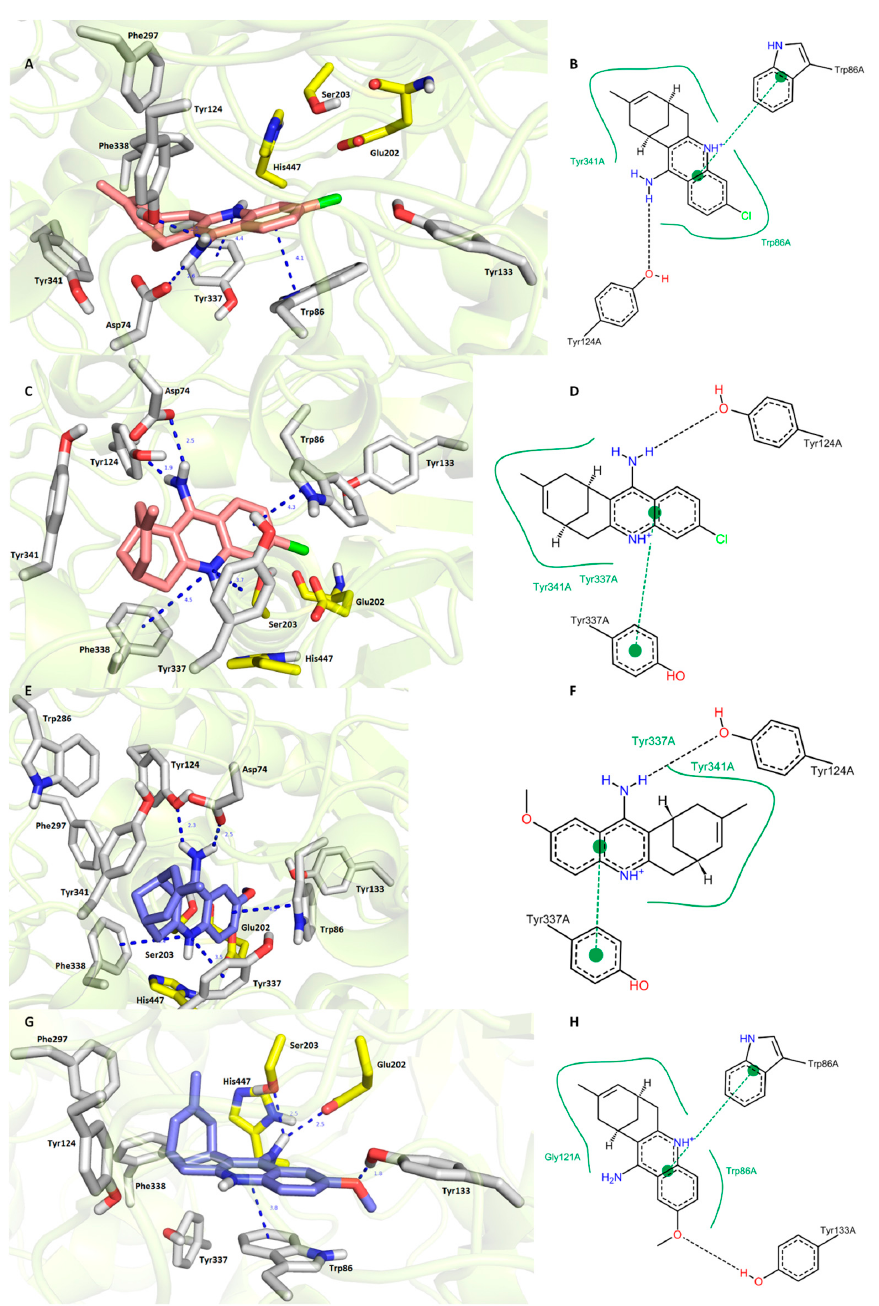
Figure 4. Docking results for HupY (( A , B )—7 R ,11 R -HupY; ( C , D )—7 S ,11 S -HupY) and 1 (( E , F )—7 S ,11 S - 1 ; ( G , H )—7 R ,11 R - 1 ) within h AChE active site (PDB ID: 4EY7). Generally to ( A , C , E , G )—HupY is rendered in salmon carbon atoms; 1 is depicted in dark blue carbon atoms; important amino acid residues involved in the ligand–enzyme interactions are displayed in grey carbon atoms; catalytic triad residues (Glu202, Ser203, His447) are shown in yellow; rest of the enzyme is represented in grey cartoon; ( B , D , F and H )—2D representation of binding modes of HupY and 1 . Figures ( B , D , F, and H ) were created with PoseView software (PoseView, http://poseview.zbh.uni-hamburg.de/poseview/wizard, 2012); Figures ( A , C , E, and G ) were generated with PyMol 1.30 (The PyMOL Molecular Graphics System, Version 1.5.0.4 Schrödinger, LLC.).